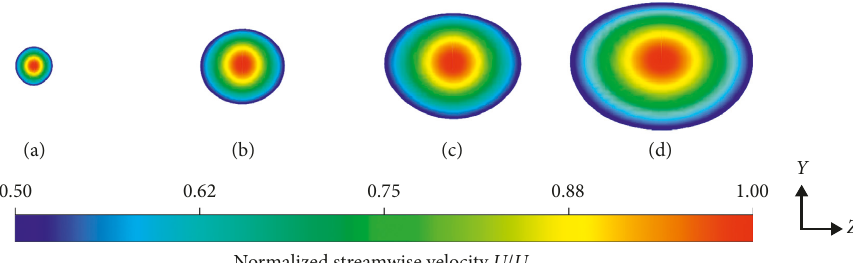
Figure 2: Jet half width regions at x � (a) 30, (b) 60, (c) 90, and (d) 120 D